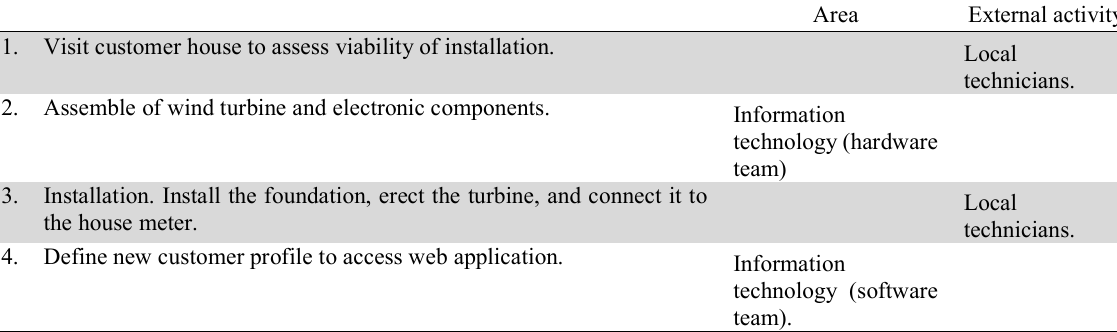
Description of the main activity “Installation of a smart wind